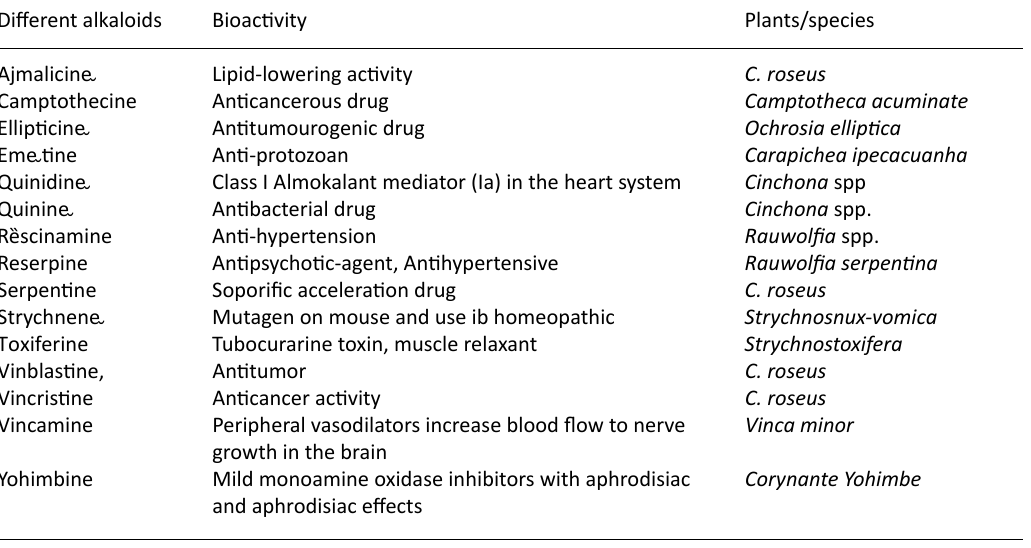
Table 1. The work of TIAs, their functions and the factory that produces them Different